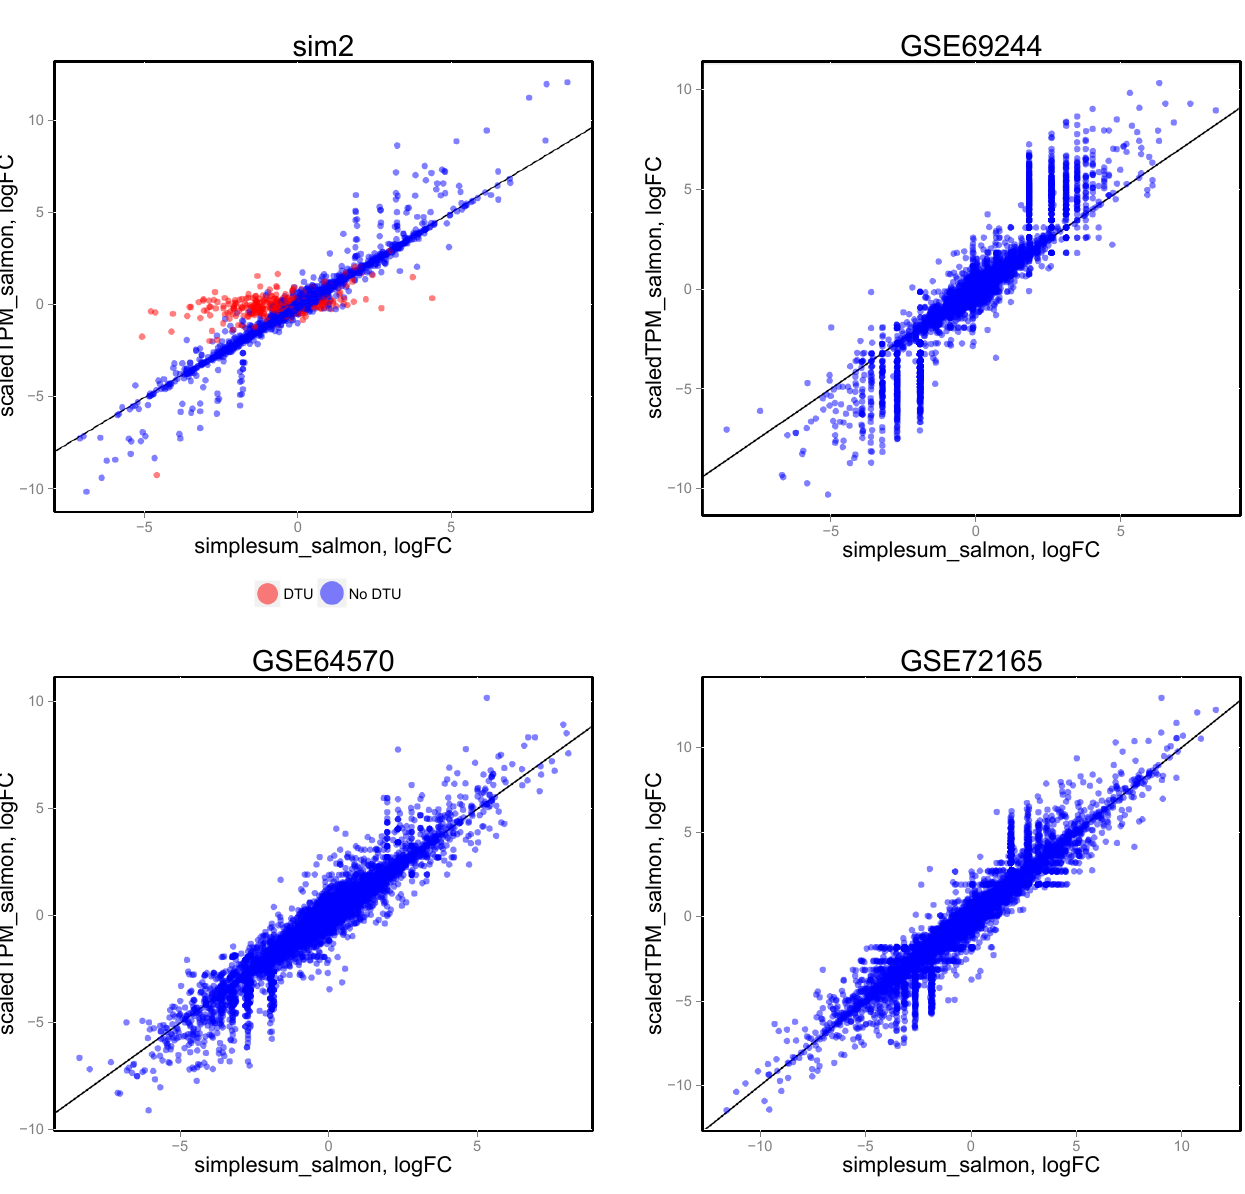
Figure 4. Comparison of log-fold change estimates from edgeR , based on simplesum and scaledTPM count matrices, in four different data sets. For the simulated data set ( sim2 ), where signals have been exaggerated to pinpoint underlying causes of various observations, genes with induced DTU (whose true overall log-fold change is 0) show a clear overestimation of log-fold changes when using simplesum counts. However, none of the real data sets contain a similar population of genes, suggesting that for many real data sets, simple gene counting leads to overall similar conclusions as accounting for underlying changes in transcript